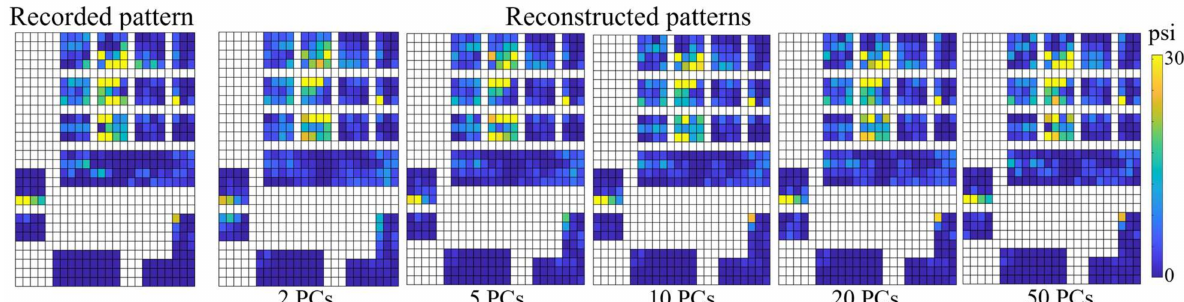
Figure 4. Comparison between the recorded and reconstructed spatial force maps using different numbers of PCs. The patterns are taken from the whole hand grasp of Subject 6 for object weight 170 g. The reconstructed patterns become more explicit and accurate when more synergies are recruited. Using only a few synergies were not able to accurately reconstruct the force patterns but were able to capture the dominant grasp force characteristics. The scale psi indicates pound force per square inch.